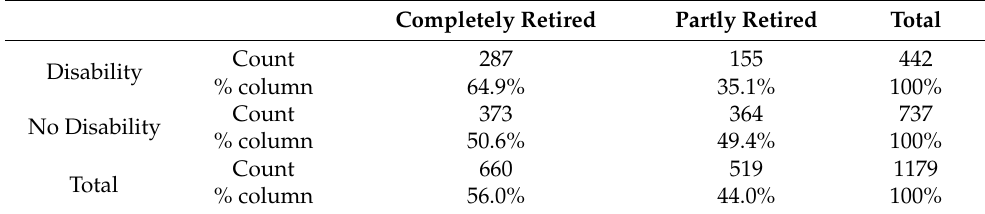
Table 5. Two-way contingency table of disability by type of